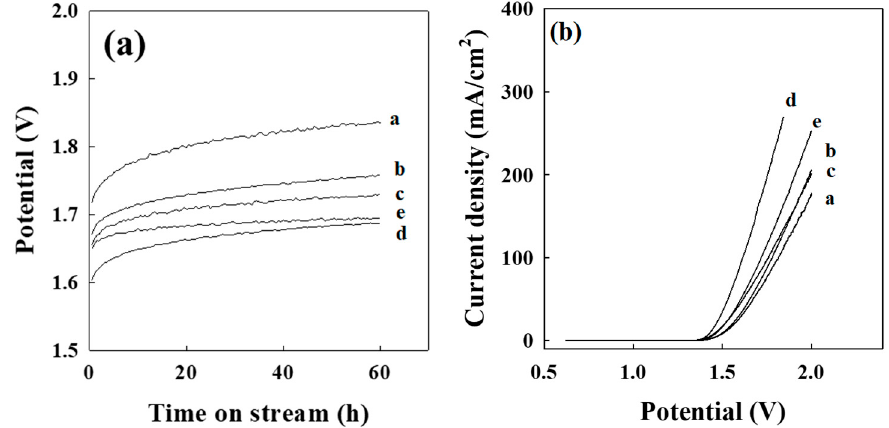
Figure 1. Electrode properties: ( a ) potential curve; ( b ) linear scan voltammograms of Pd-based electrodes viz., a: 0 g Pd-IST/TiO 2 , b: 1.8 g Pd-IST/TiO 2 , c: 4.7 g Pd-IST/TiO 2 , d: 8.6 g Pd-IST/TiO 2 , and e: 15.4 g Pd-IST/TiO 2 .